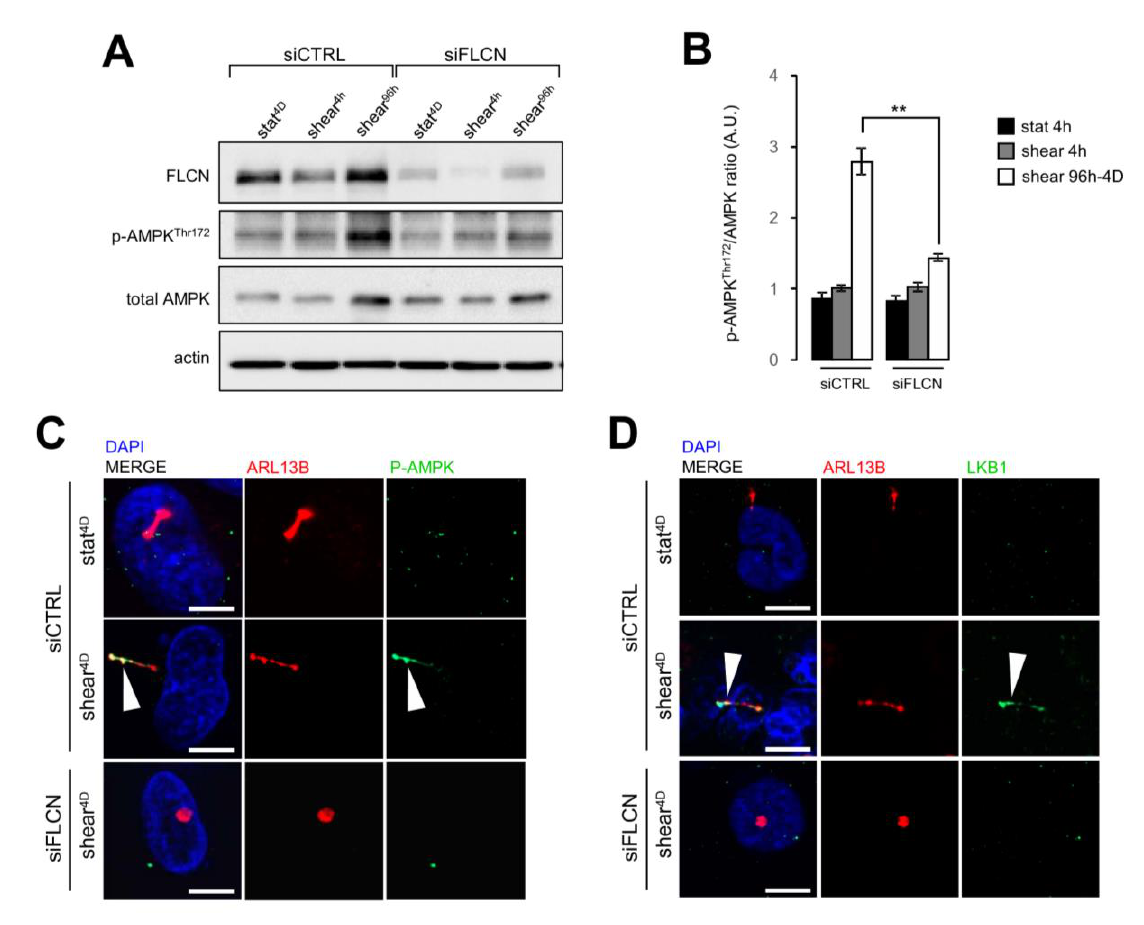
FIGURE 7: FLCN is associated with phospho-AMPK and LKBI mobilization during shear stress. HK2 cells were transfected with control siRNA (siCTRL) or with siRNA targeting FLCN (siFLCN). 72 h later, they were subjected (shear) or not (static) to fluid flow for the indicated times. (A) Phospho-AMPK (Thr172), total AMPK, FLCN and actin levels were analyzed by western blot and quantified (B ) in the indicated conditions (A). (C, D) Cells prone to fluid flow (shear 4D) or not (static 4D) were fixed with methanol, labeled with DAPI, immunostained